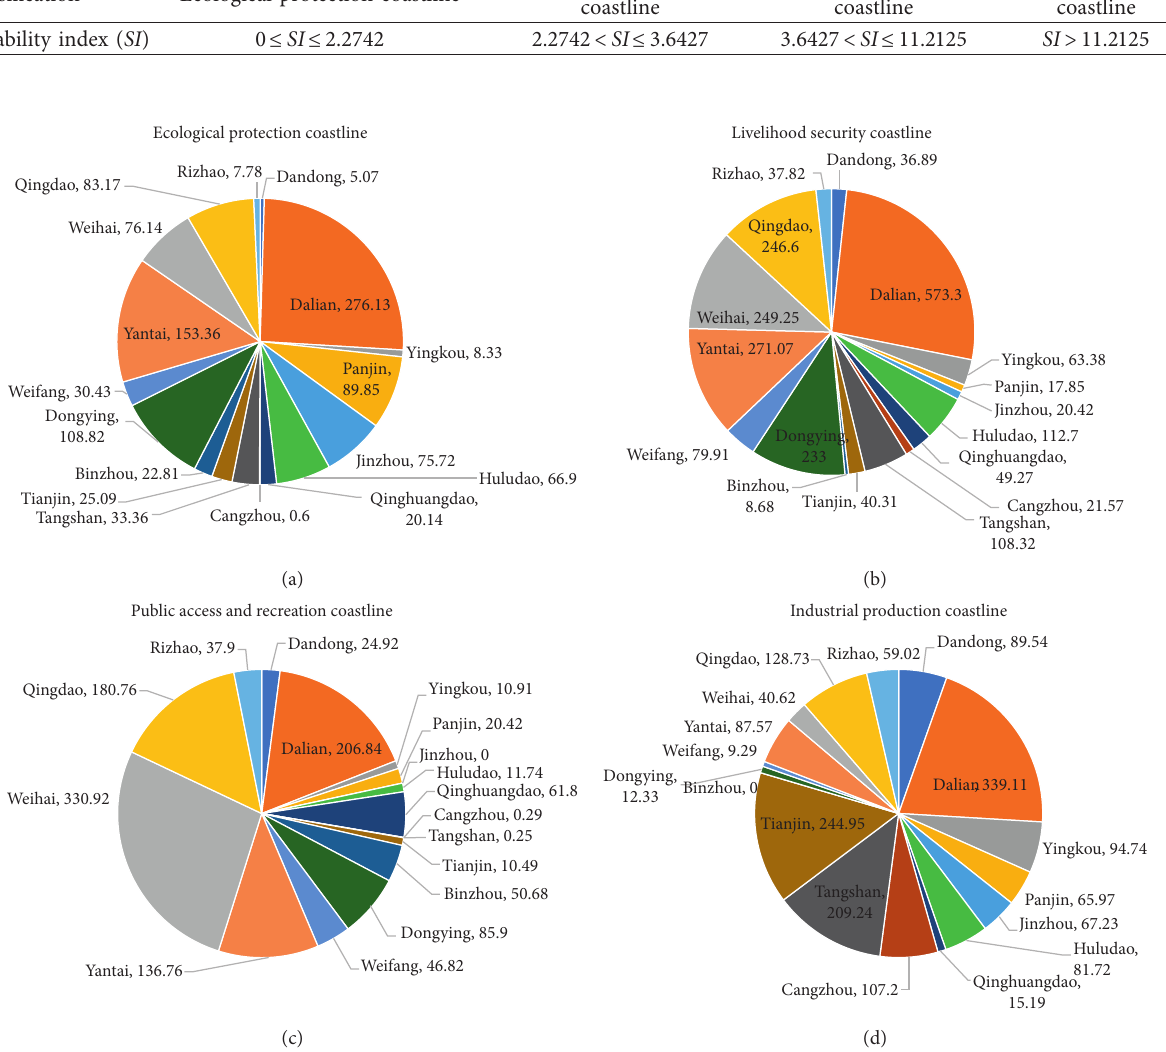
Table 3: Criteria for the classification of comprehensive utilization types of coastlines. Classification